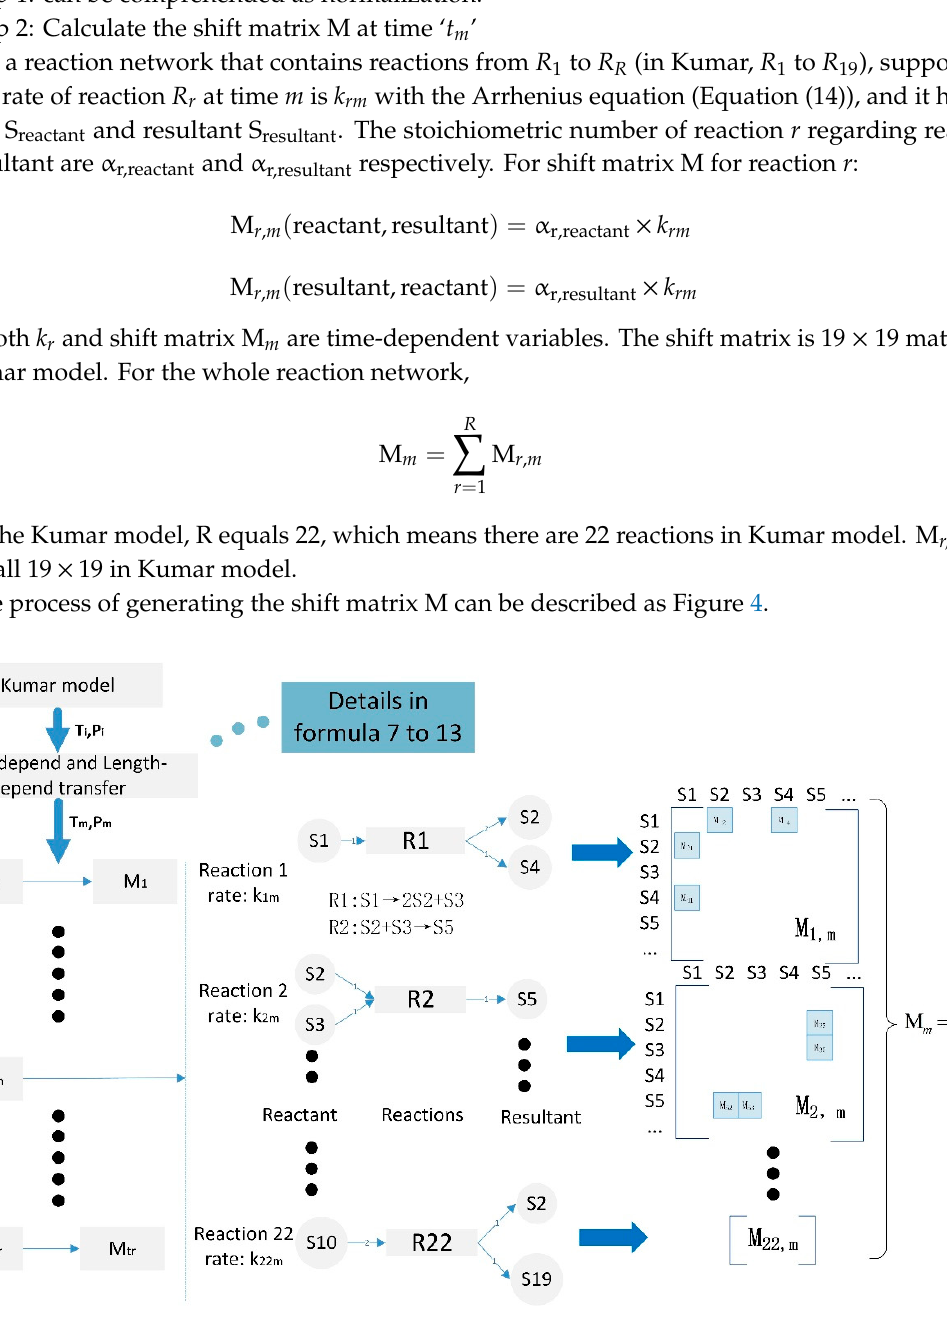
Figure 4. The generation of shift matrix M m at time m .